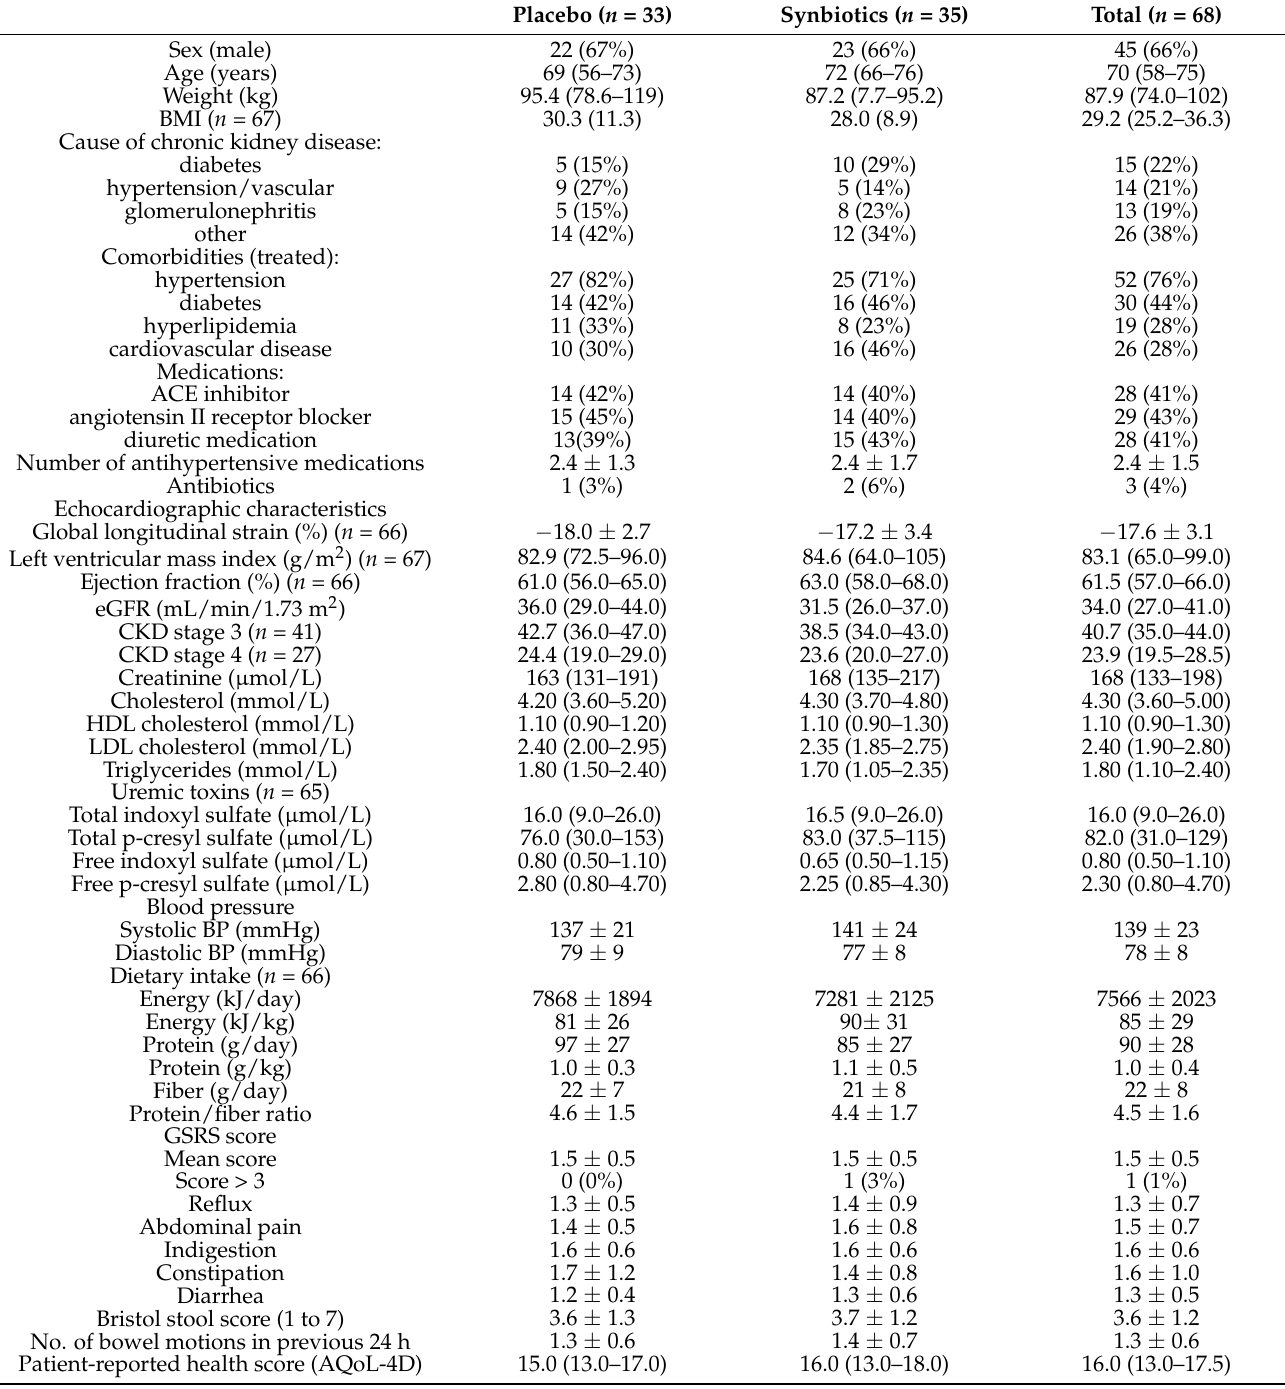
Table 1. Baseline characteristics of participants in the SYNERGY II